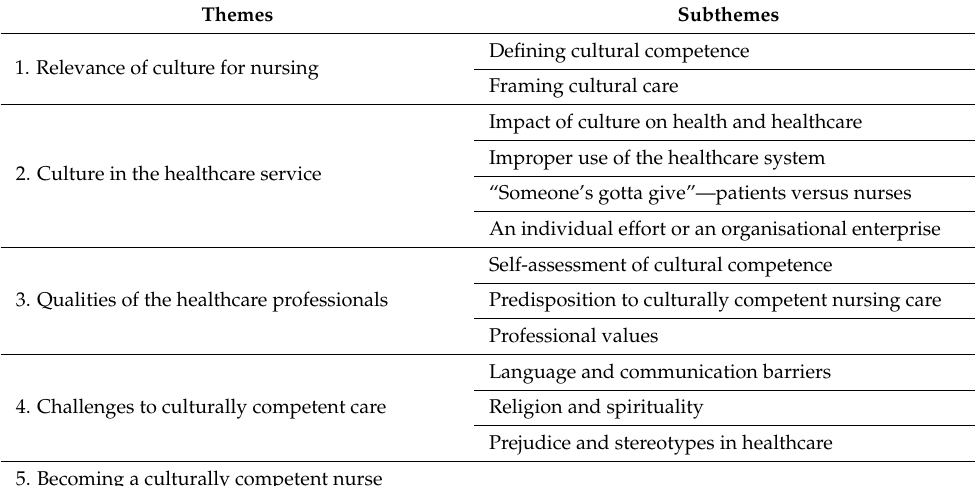
Table 3. Themes and